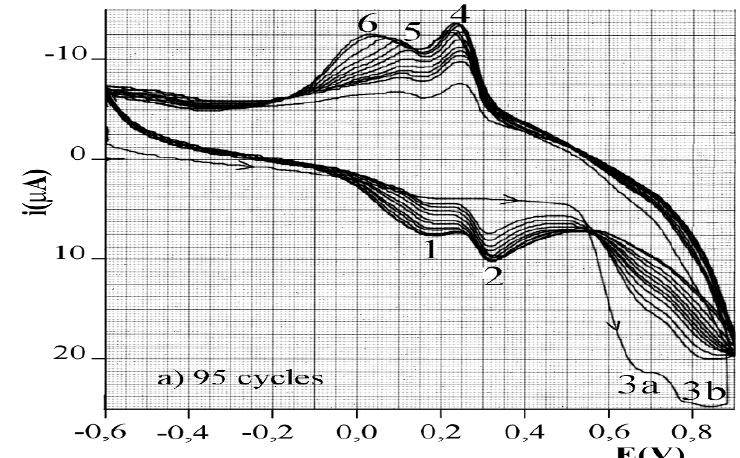
(Scan rate 100 mV s -1 ) 1-6 number of peak. Polymerization 4